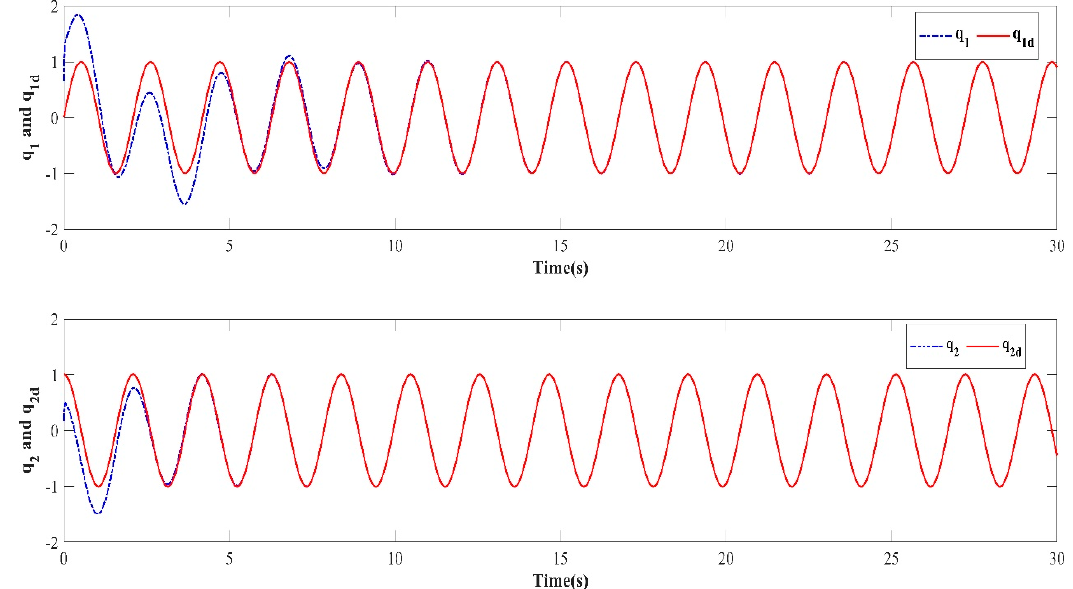
Figure 6. Learning trajectory in the seventh iteration.